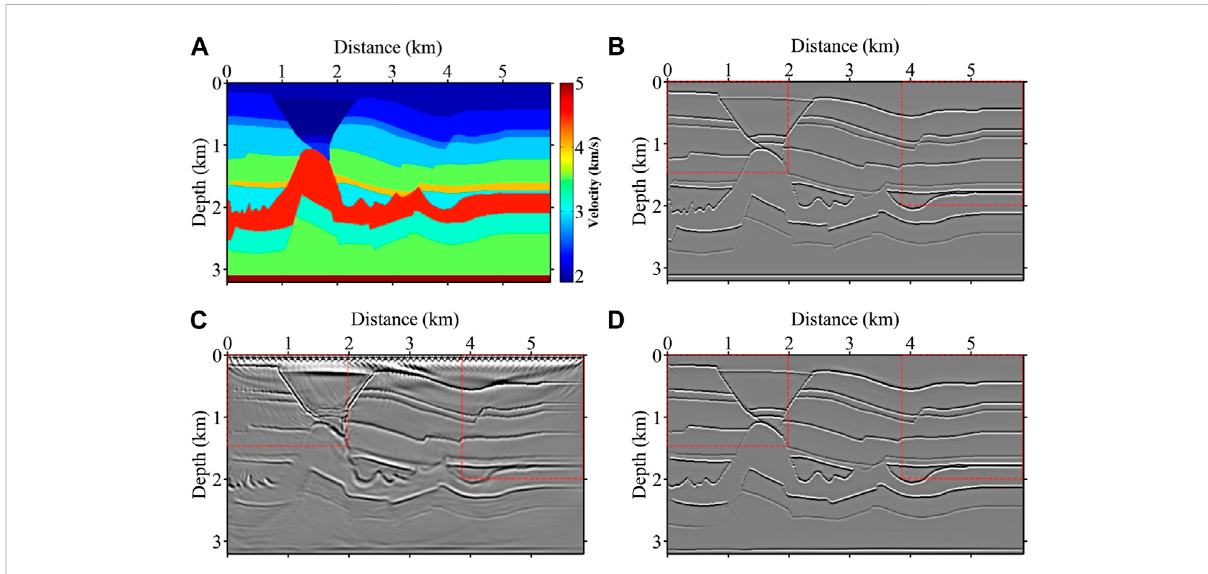
FIGURE 7 The zoom views of the red dashed boxed area in Figure 6. The fi rst column represents the RTM results (A,D) , the second column denotes the predictions (B,E) of the network and the third column is the true re fl ectivity model (C,F)